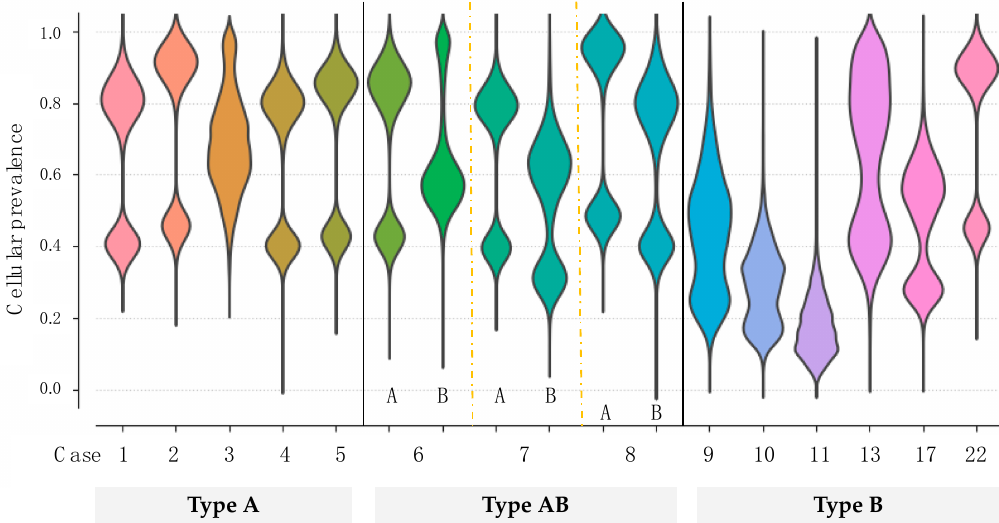
Figure 1. The cellular prevalence of GTF2I in the clonal population. The estimated cellular frequency for mutant GTF2I is represented by the distribution of the posterior probability using the PyClone model. The colored part represents the distribution of mutant GTF2I in each tumor.